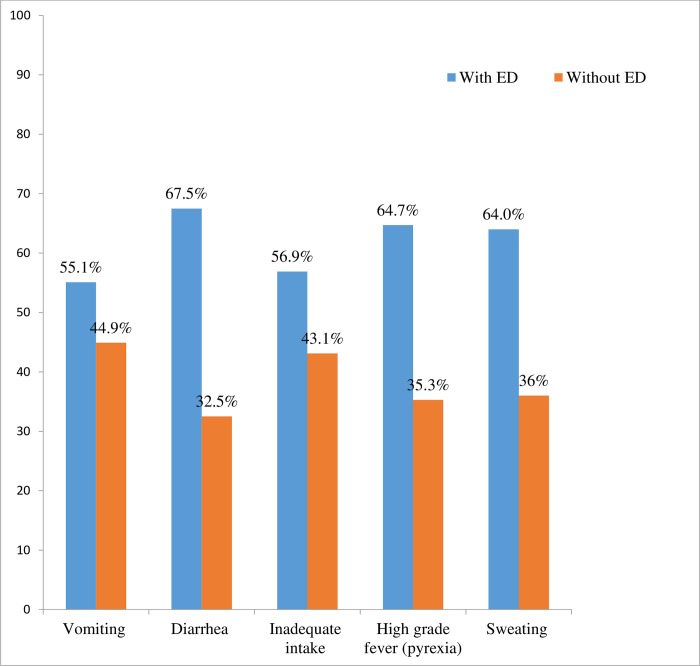
Distribution of known comorbidities precipitating for electrolyte disturbance among patients with and without electrolyte disturbance, in Jimma Medical Center, South west Ethiopia from April-May 2019.